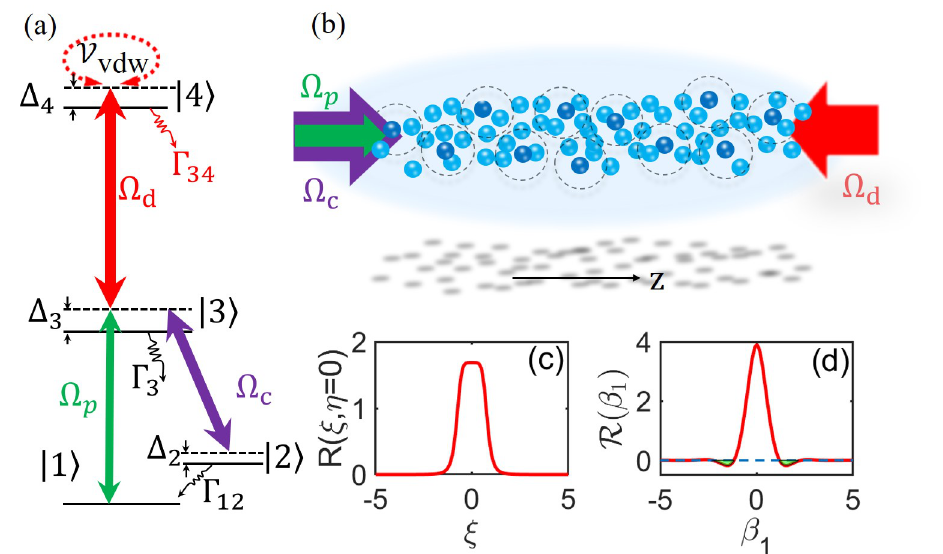
Figure 1. Schematics of the model and optical patterns: ( a ) energy level and excitation scheme of the Rydberg-dressed EIT with inverted-Y type structure. Weak probe (green), strong control (purple), and strong dressed (red) laser fields with central angular frequencies ω p , ω c , and ω d and half-Rabi frequencies Ω p , Ω c , and Ω d drive the transitions | 1 (cid:105) ↔ | 3 (cid:105) , | 2 (cid:105) ↔ | 3 (cid:105) , and | 3 (cid:105) ↔ | 4 (cid:105) , respectively. The Λ -type EIT (level | 1 (cid:105) , | 2 (cid:105) , and | 3 (cid:105) ) is dressed by highly excited Rydberg state | 4 (cid:105) . The Rydberg atoms interact with each other according to the van der Waals potential ¯ hV vdw ( r (cid:48) − r ) ≡ − ¯ hC 6 / | r (cid:48) − r | 6 . ∆ 3 is the one-photon detuning, and ∆ 2 and ∆ 4 both are the two-photon detunings. Γ αβ is the spontaneous emission decay rate from the | β (cid:105) to | α (cid:105) ( α = 1,2,3; β = 3,4 ) . The assigned atomic levels are | 1 (cid:105) = | 5 S 1/2 , F = 1 (cid:105) , | 2 (cid:105) = | 5 S 1/2 , F = 2 (cid:105) , | 3 (cid:105) = | 5 P 3/2 , F = 3 (cid:105) , and | 4 (cid:105) = | nS 1/2 (cid:105) . For principle quantum number n = 60, C 6 = − 140 × 2 π GHz µ m 6 ; ( b ) possible experimental geometry, where small solid circles denote atoms, and large dashed circles denote Rydberg blockade spheres; ( c ) cross section of nonlocal response function R ( ξ , η = 0 ) as a function of dimensionless ξ = x / R ⊥ ( R ⊥ the typical radius of the probe beam); ( d ) nonlocal response function R ( ξ , η = 0 ) in momentum space as a function of wave number β 1